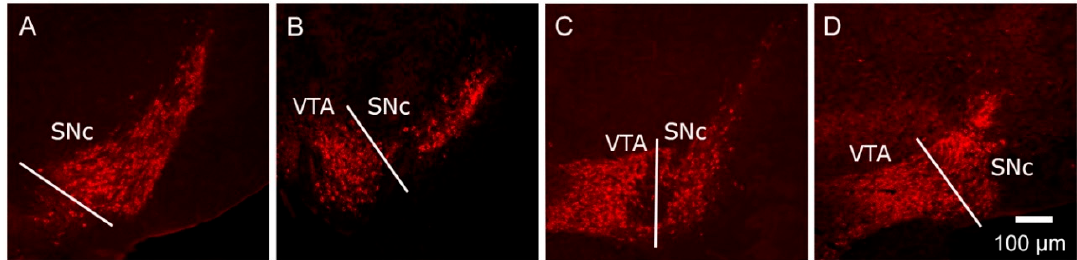
Figure 1. Representative images, moving in a rostro-caudal direction, at the different levels of the murine SNc (substantia nigra pars compacta) ( A – D ) and VTA (ventral tegmental area) ( B – D ). Brain slices were processed for tyrosine hydroxylase immunoreactivity (TH-IR) and the SNc and VTA were delineated by the TH-IR cell bodies and classical neuroanatomical landmarks. In order to detect any regional differences in shape/volume (calculated using Cavalieri’s method [91,109] and cell distribution through the nuclei, sections containing the nuclei were divided into four levels ( A – D ), each spanning 200–250 µ m, beginning at the anatomical level where the SNc TH-IR cells first appear. Representative images at each level are shown here for the mouse, with full details given in [109]. This method is analogous to that which we have used previously for analysing the rat SNc/VTA [91].